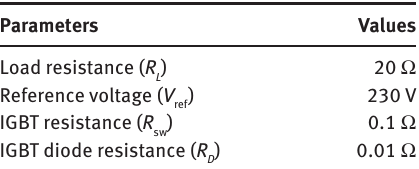
Table 1: Implementation